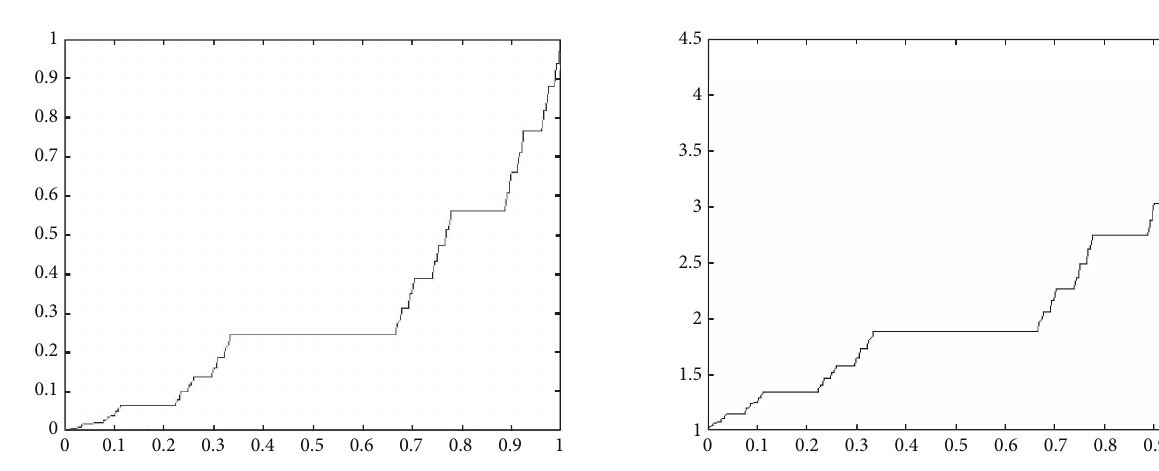
Figure 1: Graph of 𝑥 2𝛼 for 𝛼 = ln 2/ ln 3 . Figure 2: Graph of 𝐸 𝛼 (𝑥 𝛼 ) for 𝛼 = ln 2/ ln 3 .